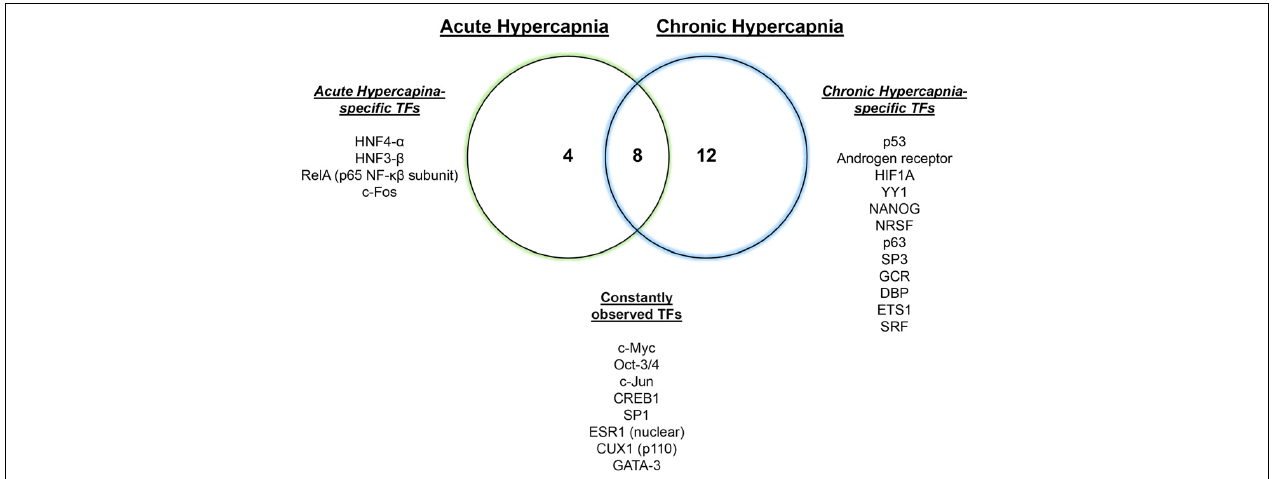
FIGURE 1 | Hypercapnia-responsive transcription factors conserved in mouse tissues. Twelve or twenty hypercapnia-responsive transcription factors (TFs) were observed during acute or chronic hypercapnia conditions in mouse lung, diaphragm and soleus, respectively. Eight conserved TFs consistently inferred gene expression signatures in the tissues during hypercapnia. Modified from Shigemura et al. (2019).